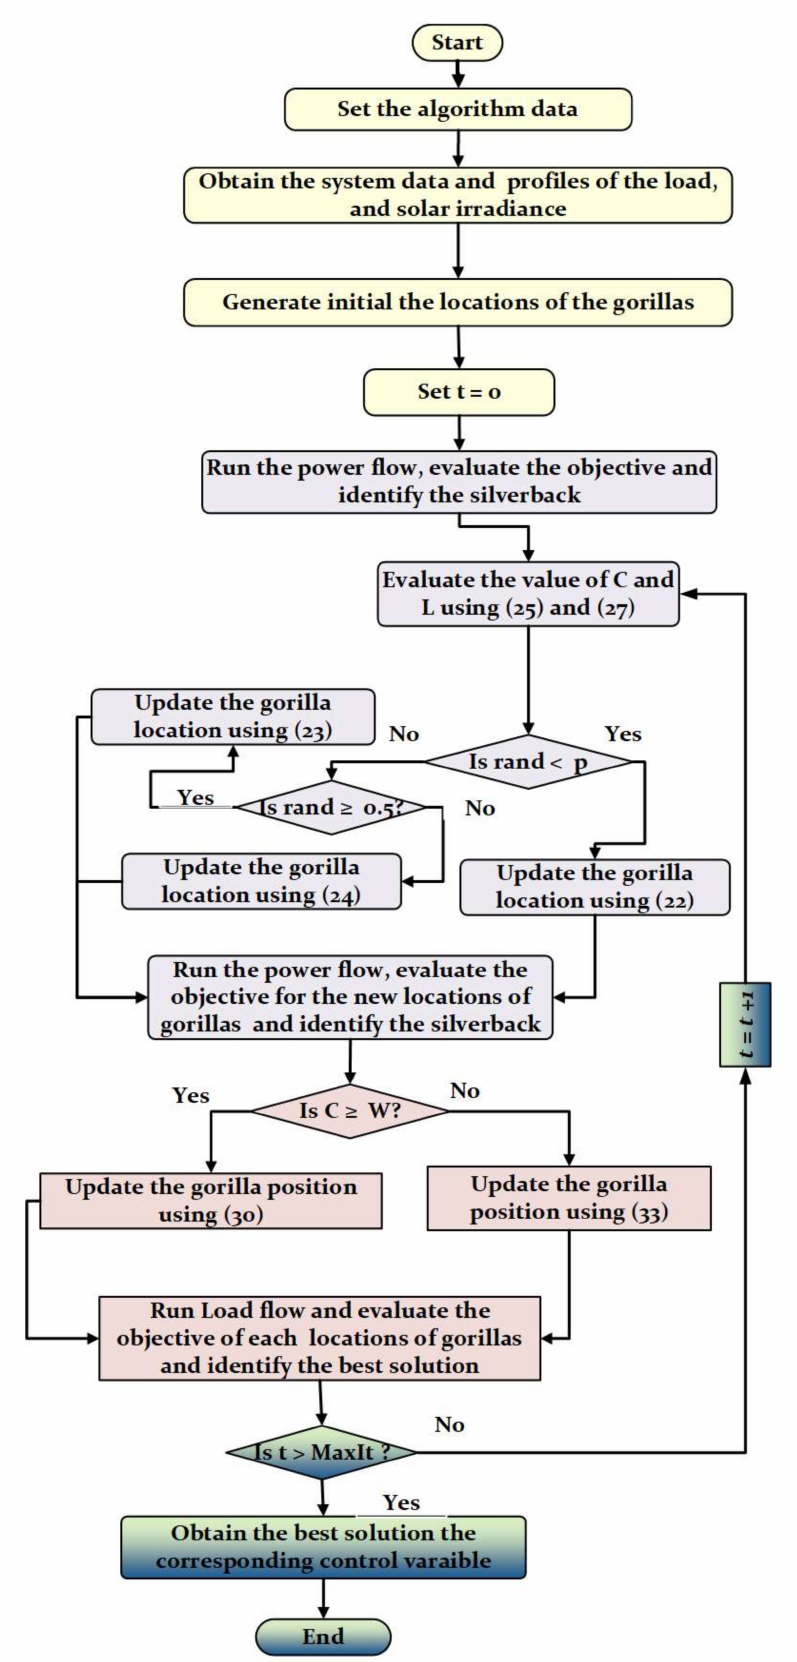
Figure 1. Flowchart of GTO application in solving the optimal allocation problem of